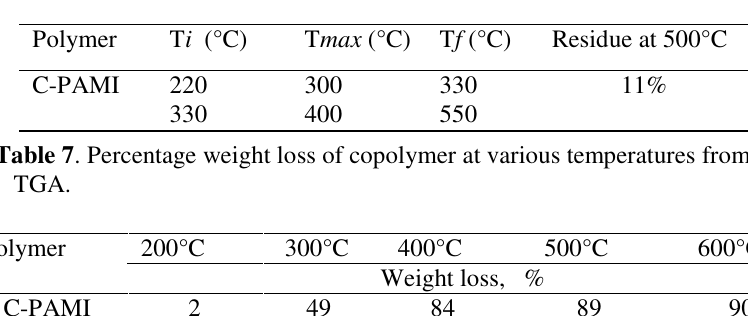
Table 6 . Thermal Behaviour of copolymer